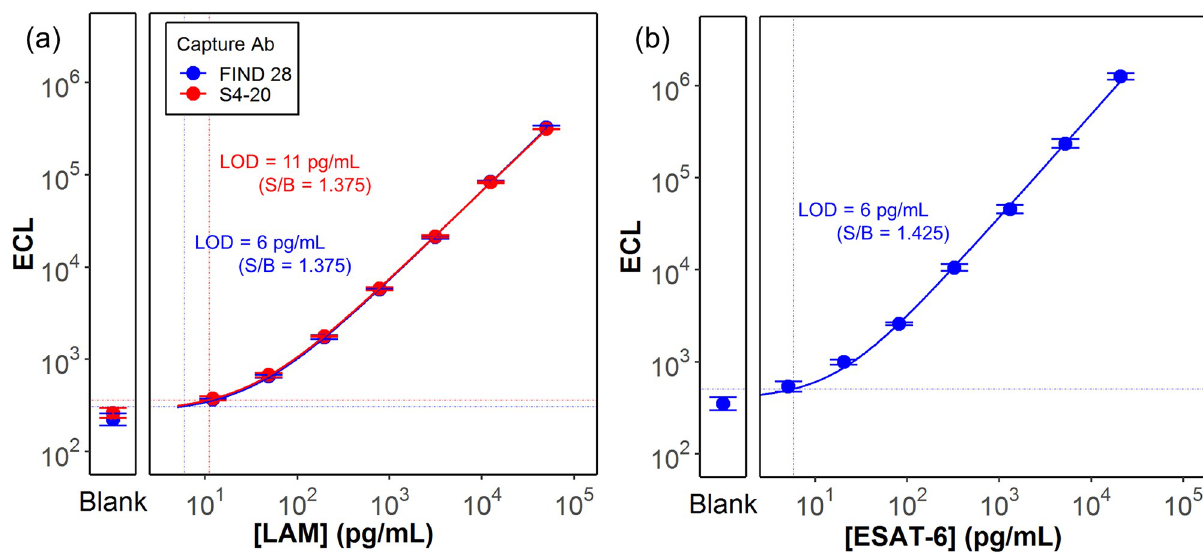
Fig 1. Calibration curves (ECL signal as a function of the concentration) for the (a) LAM and (b) ESAT-6 assays. Each panel also provides the measured signal for a blank sample containing no analyte. Solid lines show the 4PL fit to the data. The horizontal and vertical dashed lines represent, respectively, the lowest detectable signals—based on the threshold signal to background (S/B) value as described in the text—and the limit of detections (LOD) calculated from the lowest detectable signal by back-fitting to the 4PL curve.